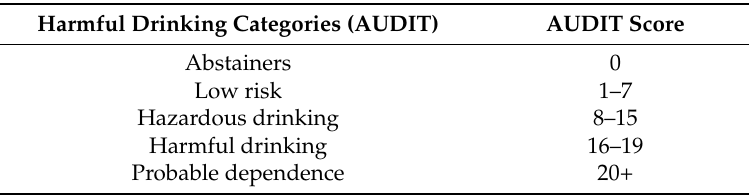
Table 1. Harmful drinking category (AUDIT) scoring.